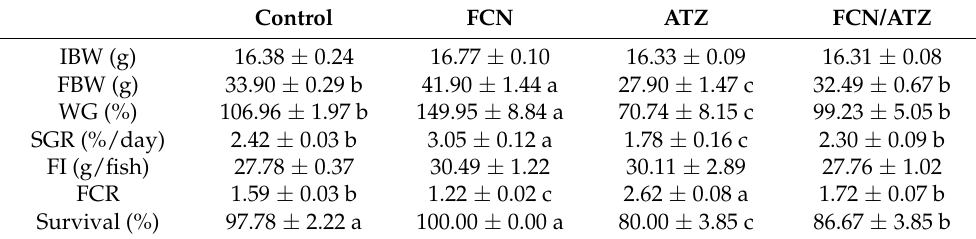
Table 1. Growth performance of Nile tilapia fed fucoidan and exposed to